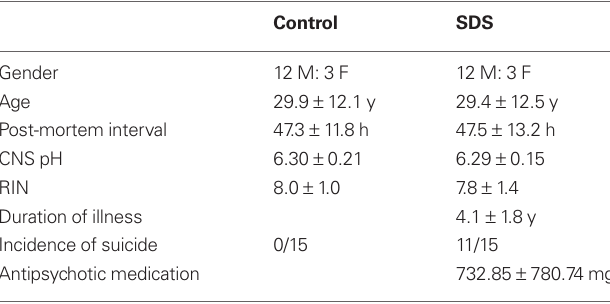
Table 1 | A summary of the demographic and tissue condition data for subjects with short duration of illness schizophrenia (SDS) and control subjects used in the study. Gender data is described as the ratio of males (M) to females